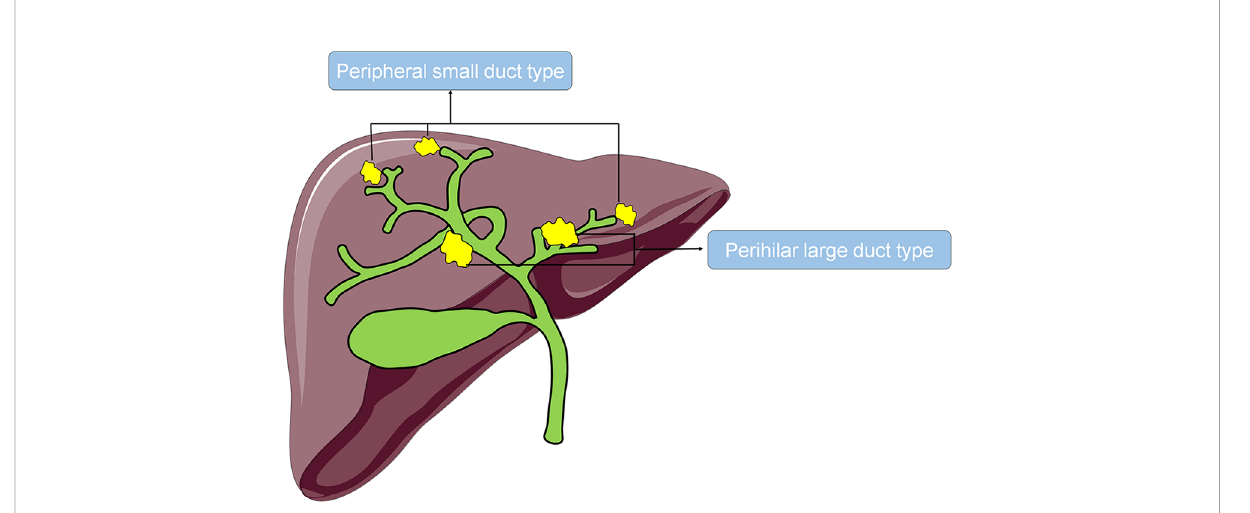
FIGURE 1 Tumor location of iCCA phl and iCCA pps